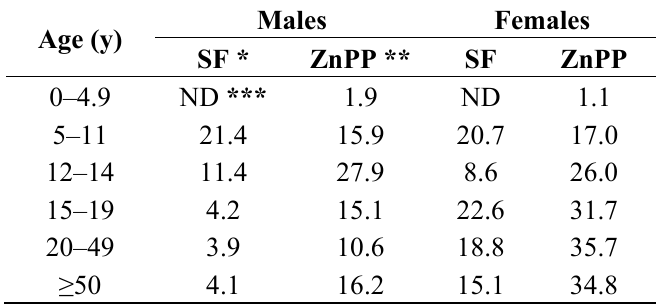
Table 2. Prevalence of iron deficiency * by age and gender in Kuwaitis. Age (y)